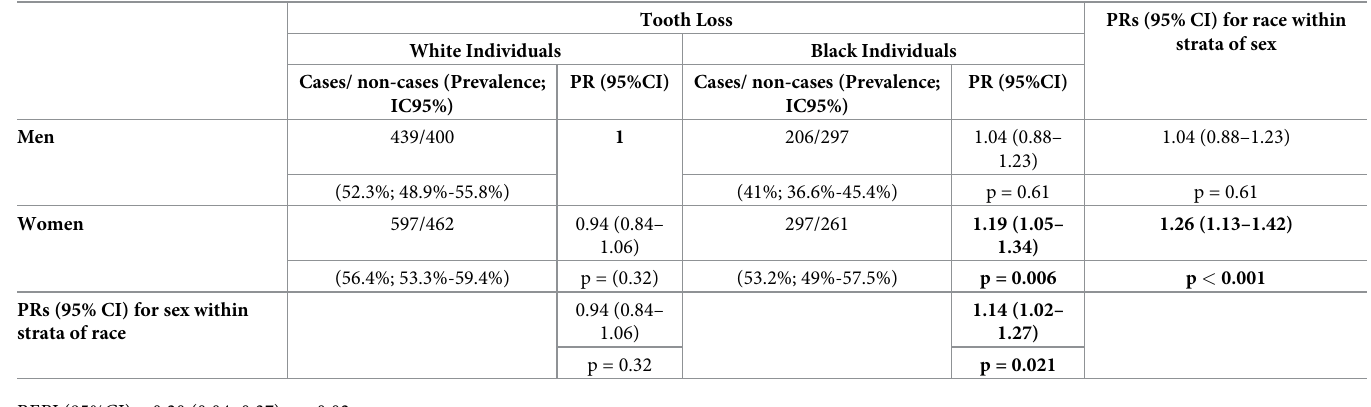
Table 1. Adjusted Prevalence Ratios (PRs) for tooth loss comparing sex and race groups (ISACamp